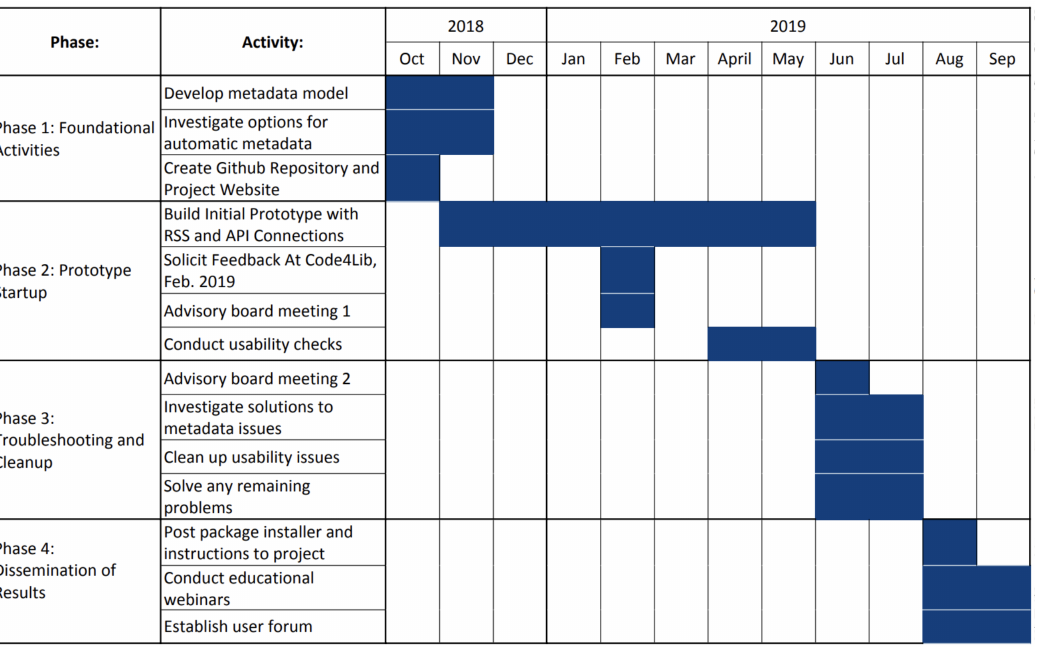
Figure 1. The Dataset Search prototype.